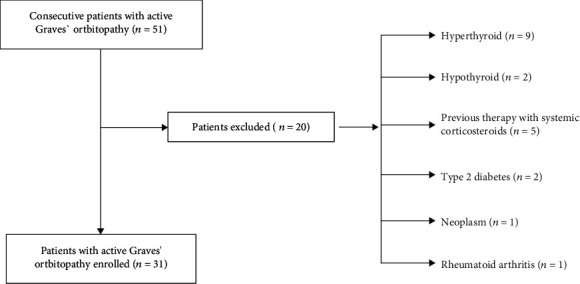
Study flow chart.